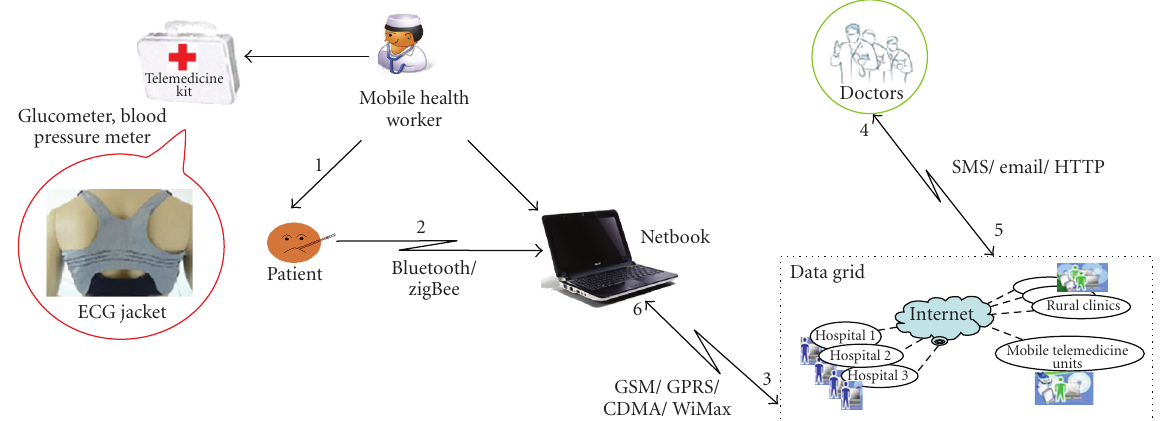
Figure 1: Life cycle of a patient request in